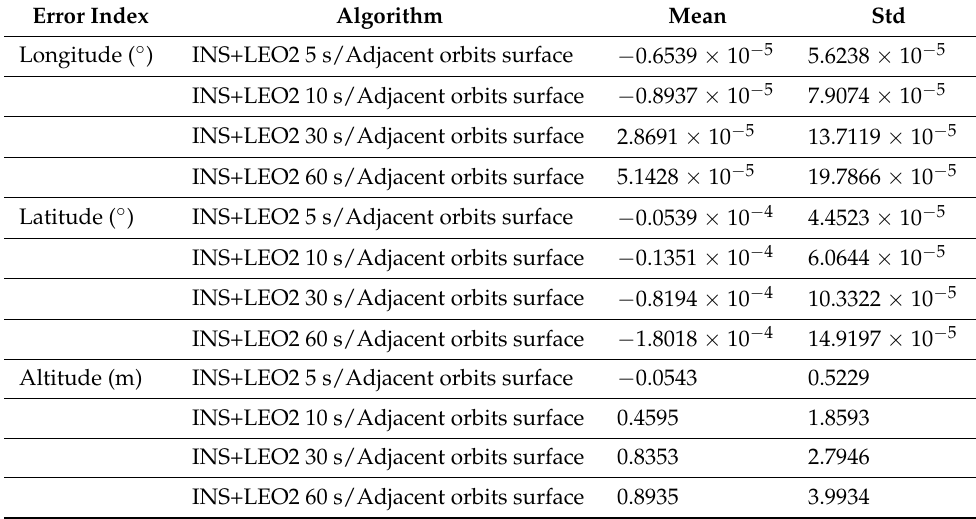
Table 5. The trajectory error